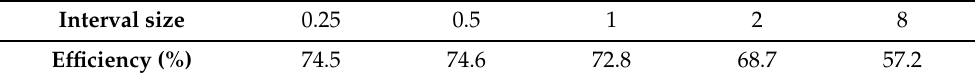
Table 3. The efficiency values under different chromosome designs, i.e., different speed intervals. Interval